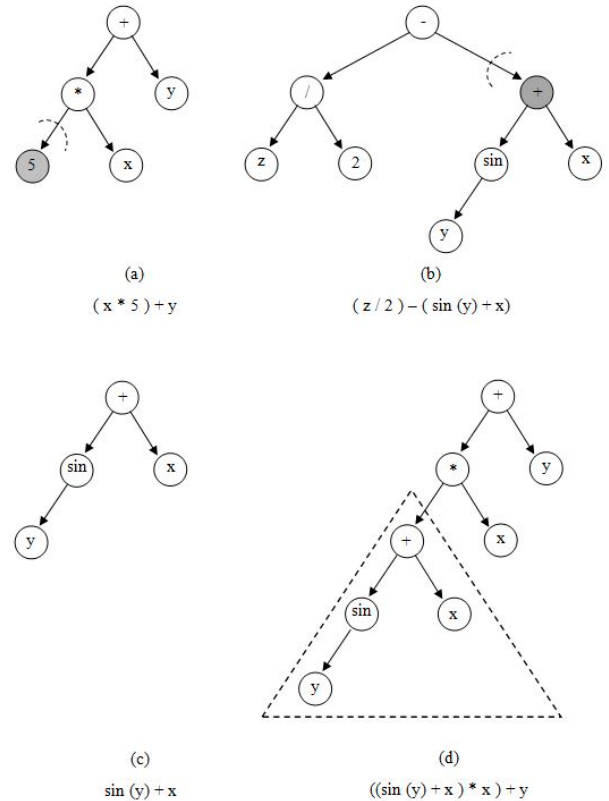
Figure 7. Information sharing mechanism of ABCP algorithm. ( a ): x i ; ( b ): x k ; ( c ): neighbor